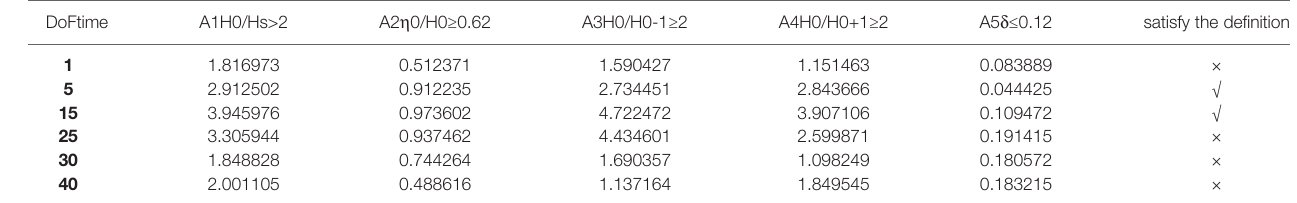
TABLE 1 | Recording and veri fi cation of the characteristic parameter values. DoFtime